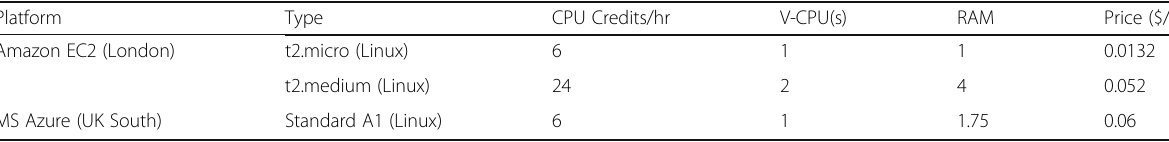
Table 1 Hardware configrations for cloud platforms